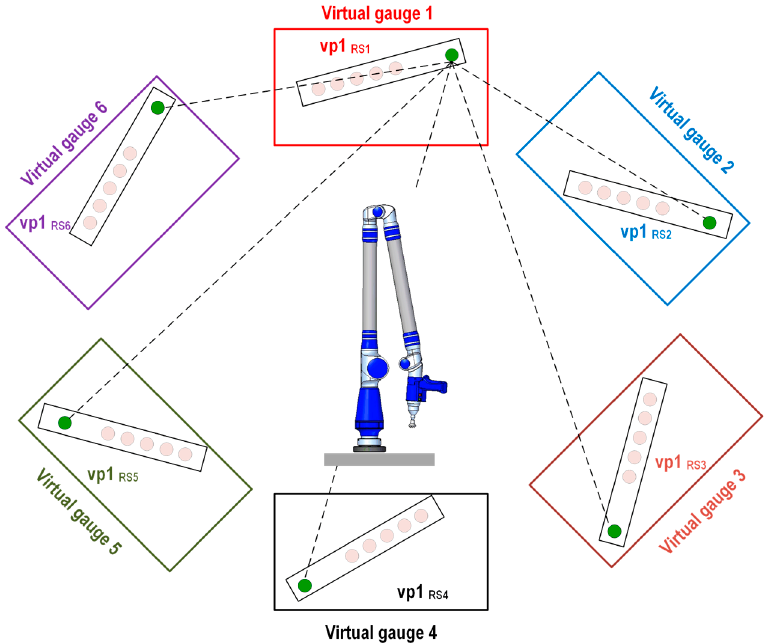
Figure 6. Evaluation method 1: virtual distance between virtual point in gauge 1 and equivalent virtual points in virtual gauges (2–6).